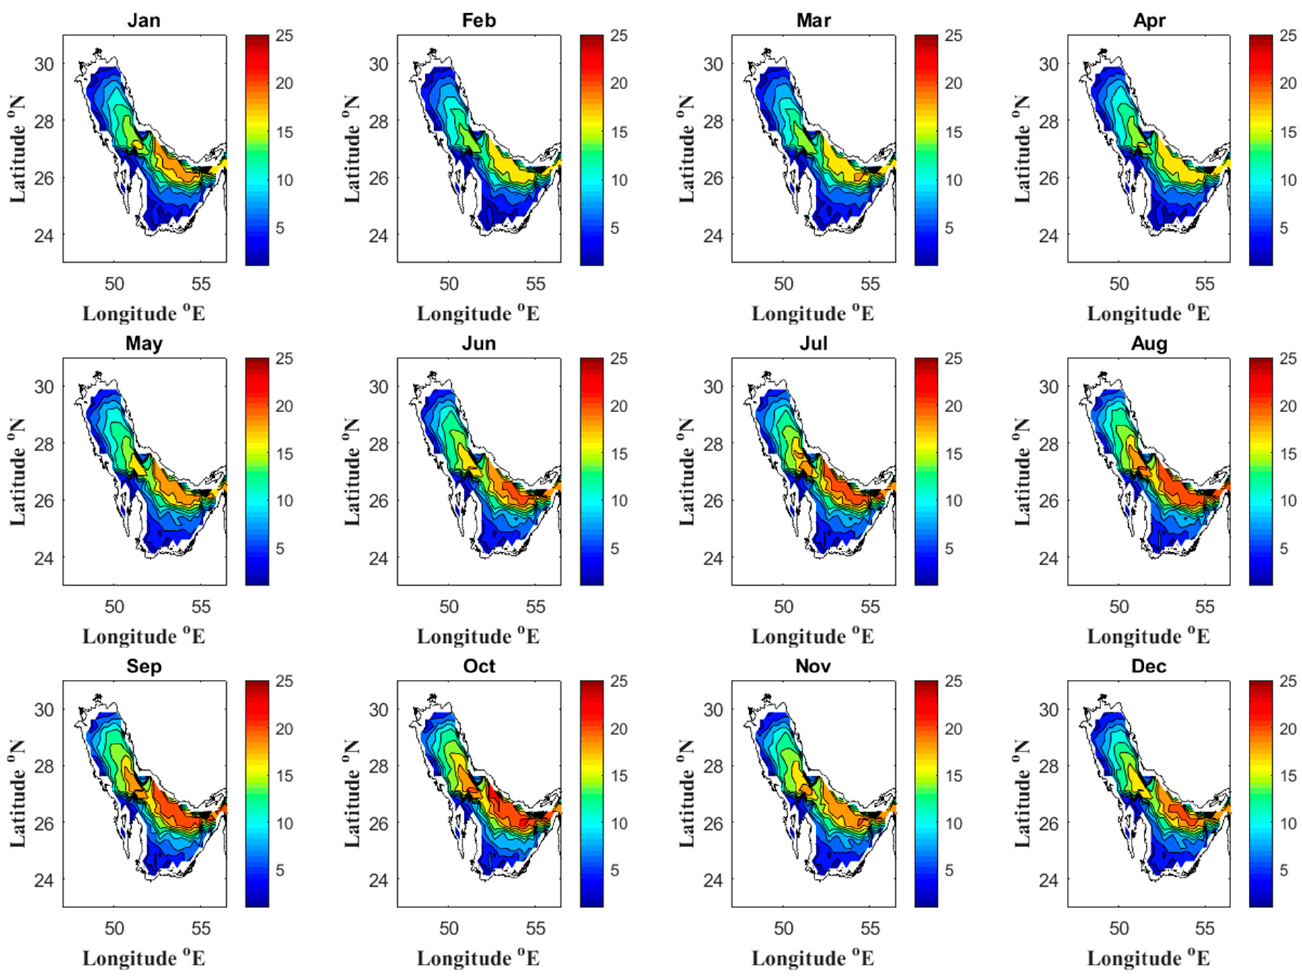
Figure 3. Heat content ( × 10 7 Jm − 2 ) for the water column to the maximum depth for every month.